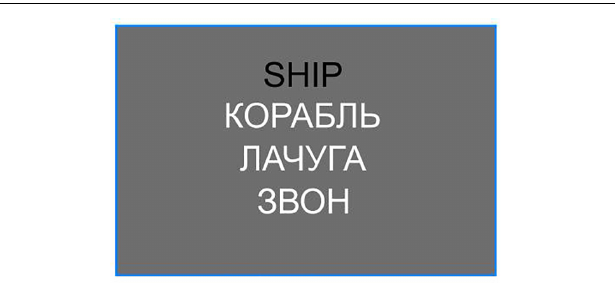
FIGURE 1 | Vocabulary test slide example. The participant chose correct translation by pressing keyboard buttons 1, 2, or 3. In this example the correct answer is 1 (“ КОРАБЛЬ ” = “ship”). The distractors are “shack” ( ЛАЧУГА ) and “toll” ( ЗВОН ).